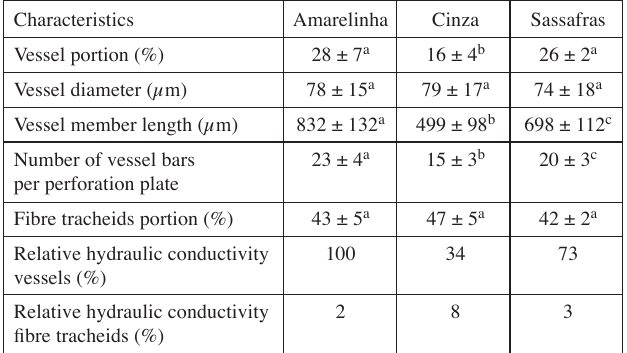
(Fig. 5b/c). The lowest formation of conneting vessel elements and fibre tracheids and the strongest formation of a protective layer were found in root stocks of the phenotype “Cinza” connected to buds of the phenotype “Amarelinha” (Fig. 5c).